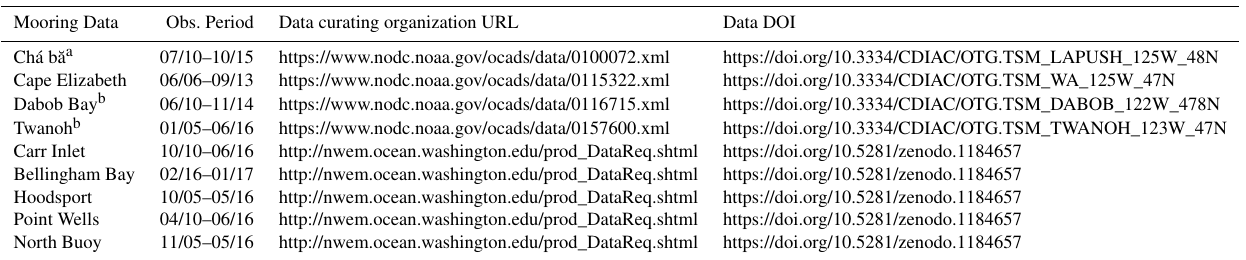
Table 3. Data attribution table listing the mooring datasets (with observing periods) incorporated into the analysis. Data curating organization URLs and data DOIs are